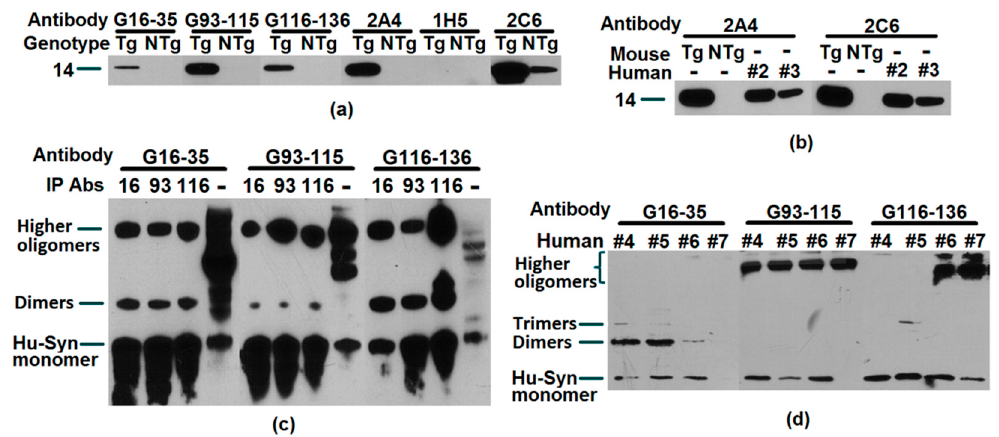
Figure 2. Antibodies with high affinity for human α -syn. ( a ) Western blotting result of antibodies (G16-35, G93-115, G116-136, 2A4, 1H5, and 2C6) probing α -syn in transgenic (Tg) and non-transgenic (NTg) mouse brain protein lysate; ( b ) Western blotting result of mouse monoclonal antibodies (2A4 and 2C6) probing Human α -syn in brain protein lysate of transgenic and non-transgenic mice and 2 human samples (#2 and #3); ( c ) Western blotting results of goat polyclonal antibodies (G16-35, G93-115 and G116-136) probing α -syn in human brain tissue IP with G16-33(16), G93-115(93), G116-136(116) antibodies, and human brain tissue with no-IP control; ( d ) Western blotting result of goat polyclonal antibodies (G16-35, G93-115, and G116-136) probing four human plasma samples (#4, #5, #6 and #7) IP with G93-115. The high affinity of all the antibodies listed above for human α -syn could help in future an animal human α -syn model.